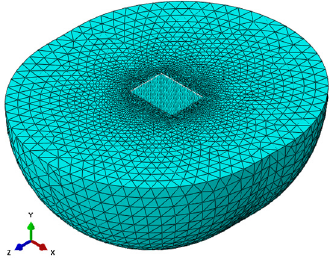
Figure 5. Finite element model of the structure flow field (half).